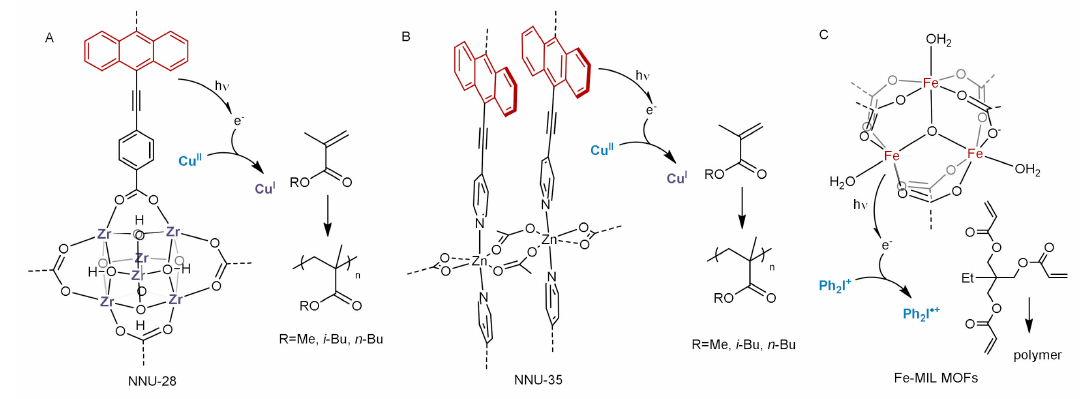
Figure 8. Scheme illustration of the mechanisms for MOF photo-initiated radical polymerization with NNU-28 ( A ), NNU-35 ( B ), and Fe-MIL MOFs ( C